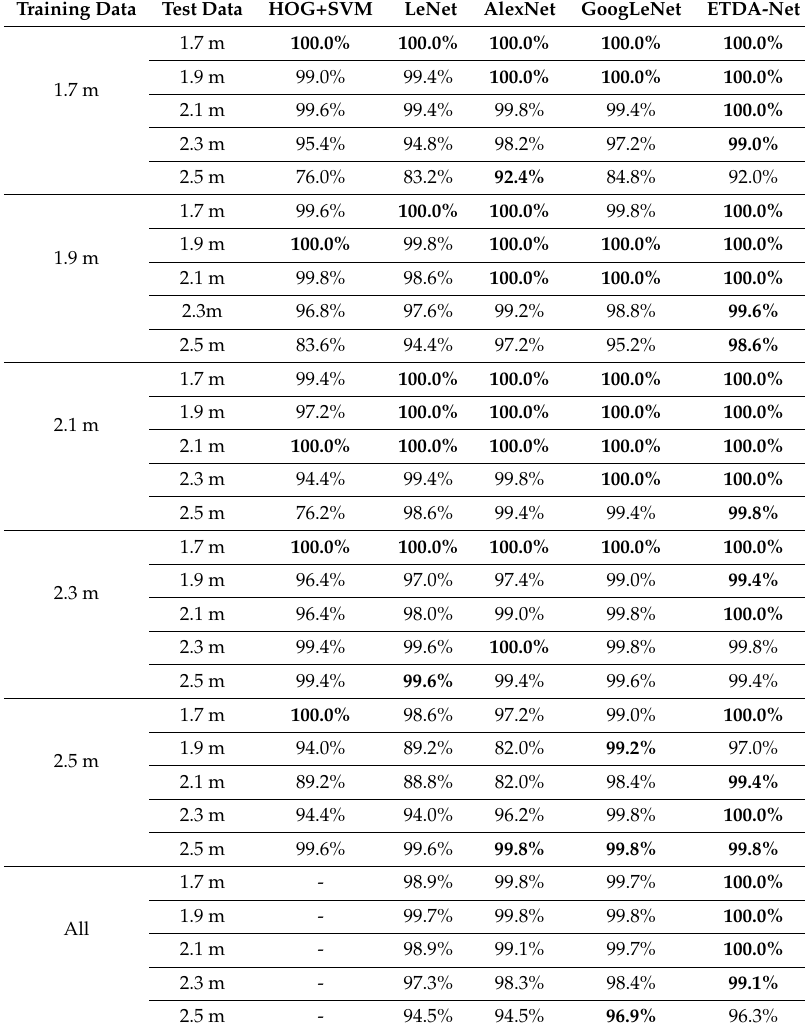
Table 5. Experimental results from specificity